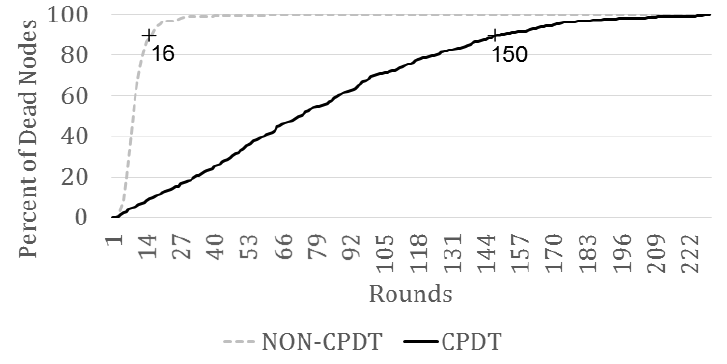
Figure 8. Percent of dead node per round.